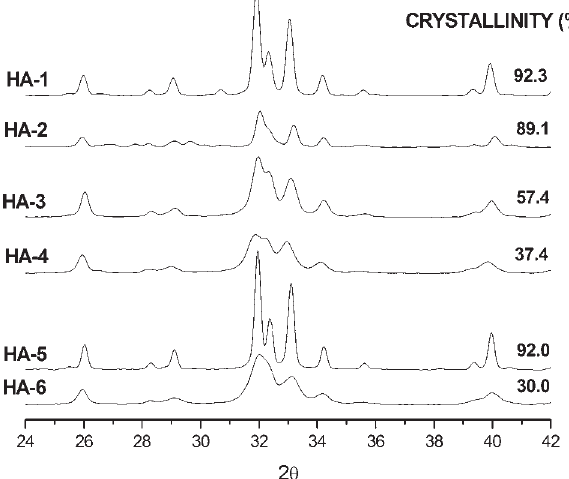
FIGURE 2- XRD pattern (displayed range in 20-60°) of all hydroxyapatite samples. No other phase than hydroxyapatite was identified. Crystallinity varied from 30 to 92 %